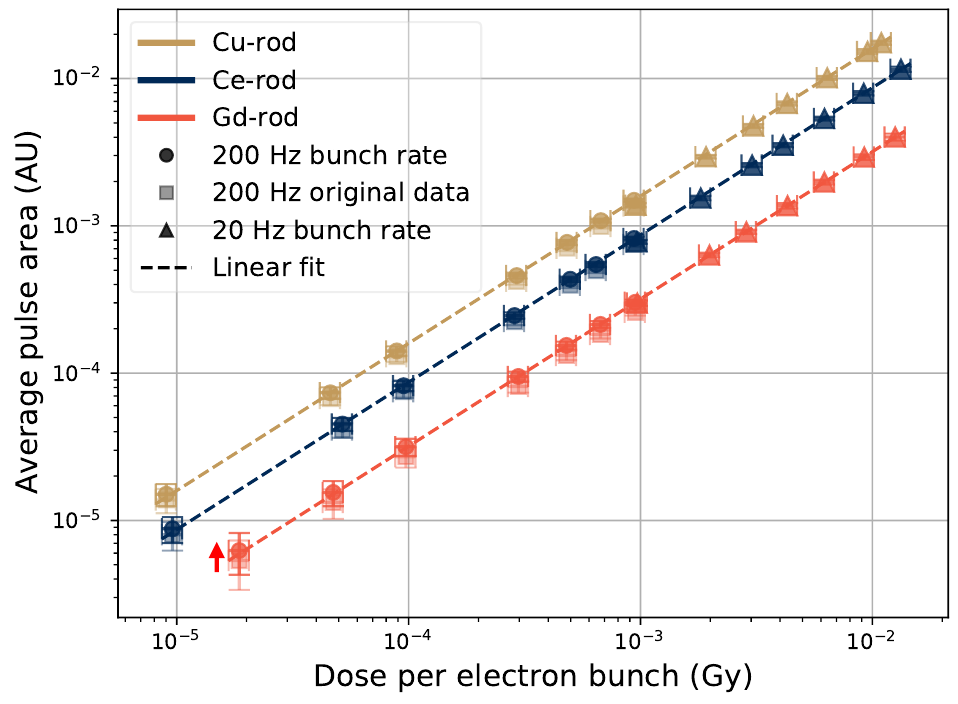
Figure 11. Pulse area as a function of electron bunch size in the samples. The average pulse area is shown for electron bunch rates of 20 Hz and 200